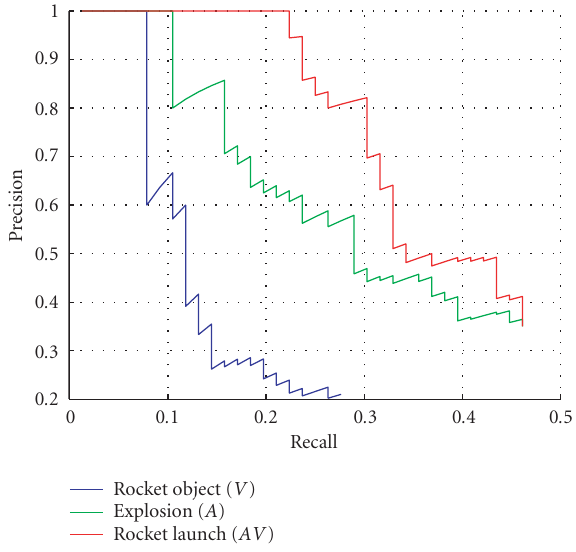
Figure 9: Precision-recall curves for up to 100 retrieved items us- ing the Bayesian network to retrieve video clips depicting rocket launch/take-o ff .